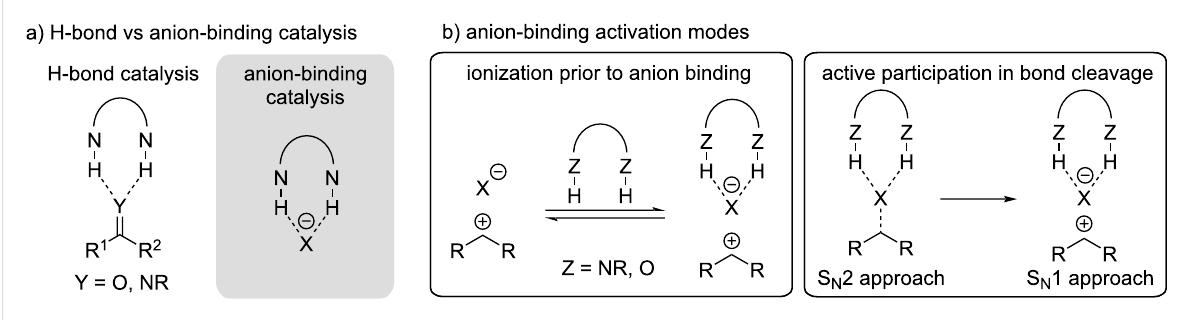
Figure 2: a) H-bond vs anion-binding catalysis and b) activation modes in anion-binding catalysis.